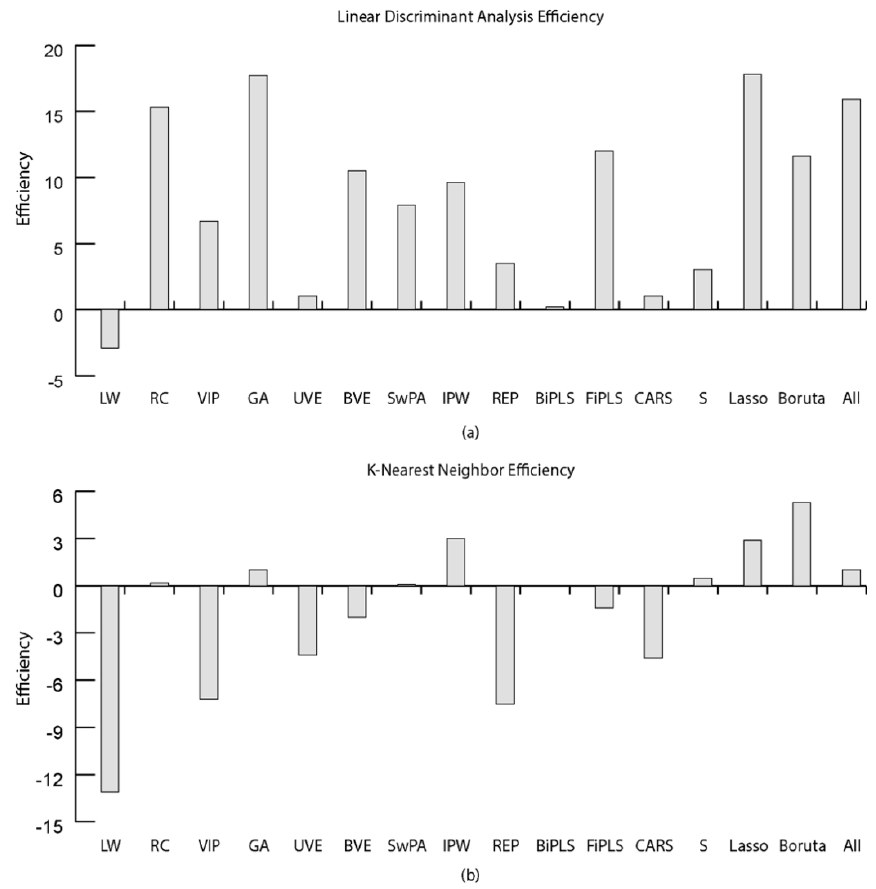
Figure 6. Efficiency of PLS method using ( a ) Linear Discriminant Analysis and ( b ) K-Nearest Neighbor.